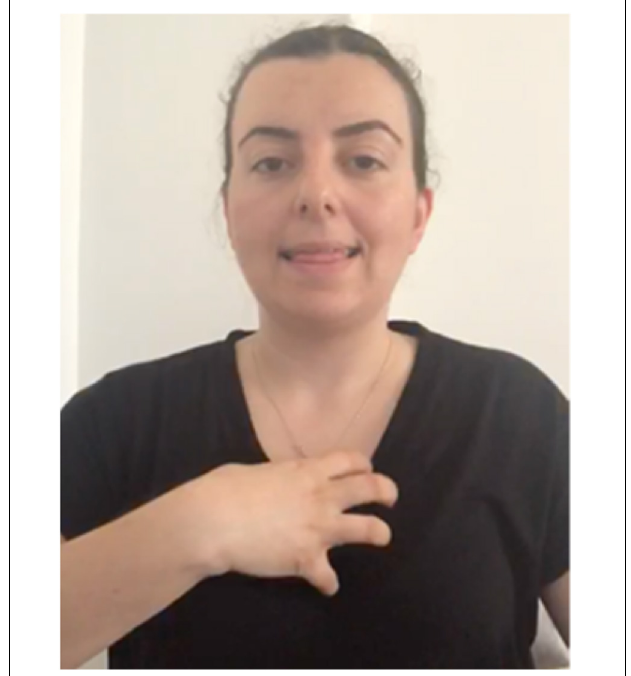
FIGURE 1 | KEND İ